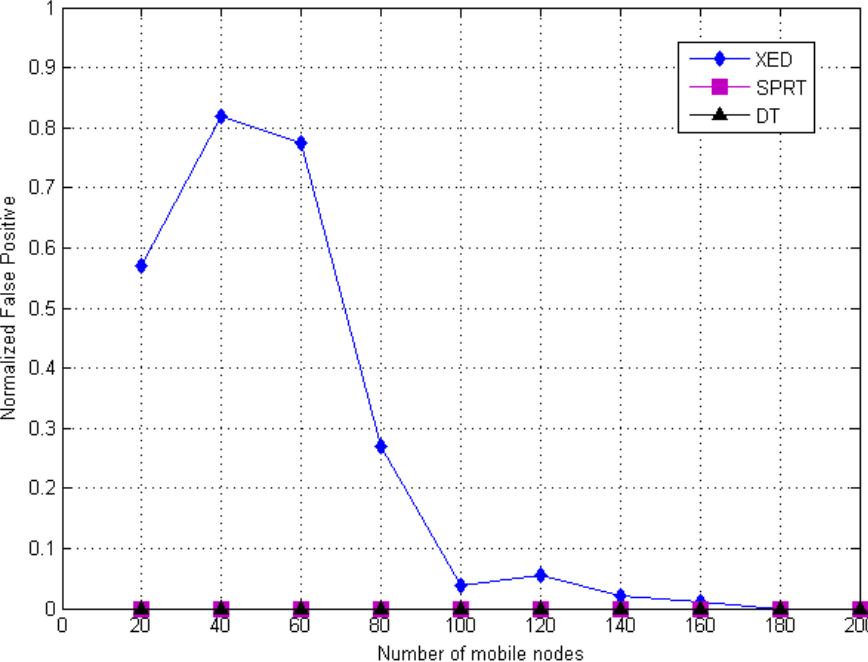
Figure 15. Comparison of simulated value of false positive rate of the DT (hybrid) detection with SPRT and